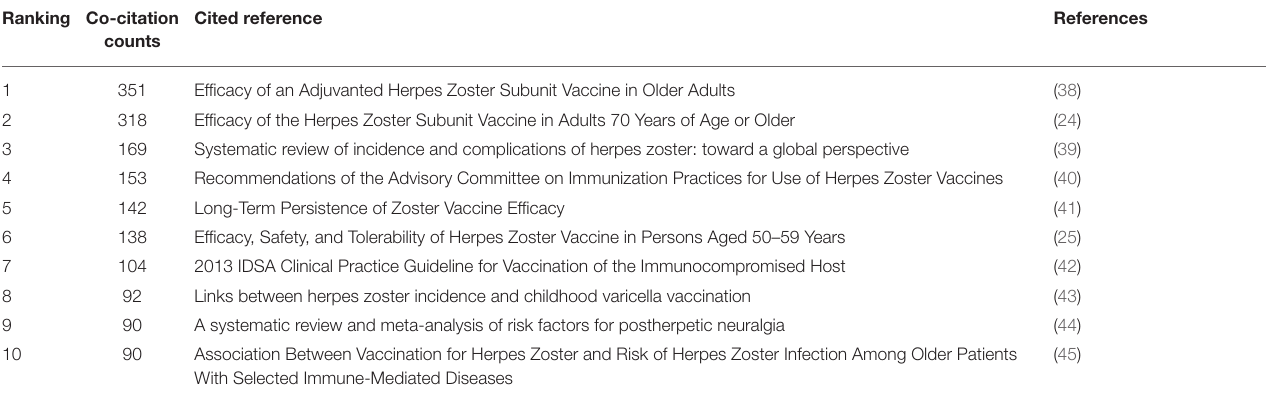
TABLE 5 | Top 10 co-cited references related to herpes zoster in terms of cocitations.